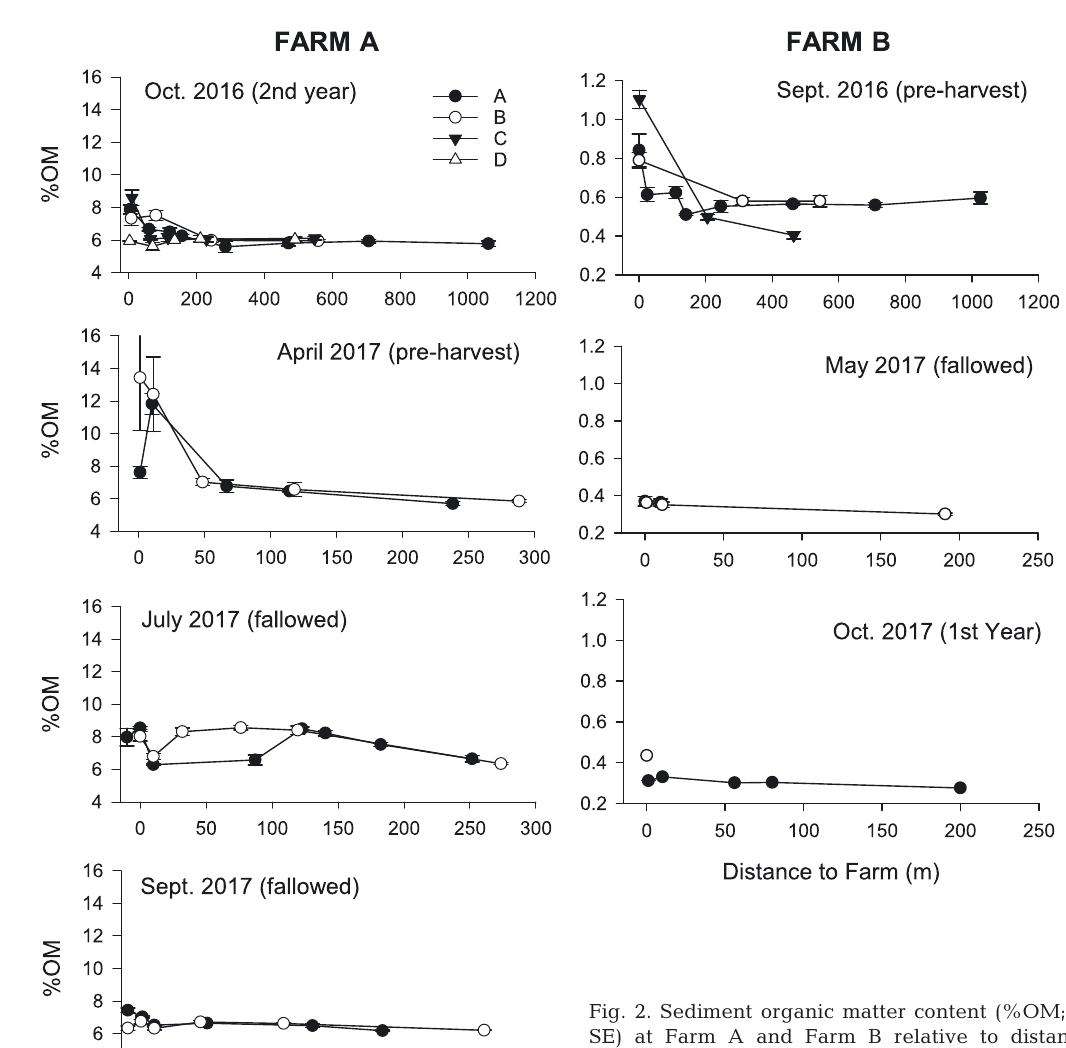
Fig. 2. Sediment organic matter content (%OM; mean ± SE) at Farm A and Farm B relative to distance from net-pens during different seasons and husbandry stages. Letters in the legend refer to sampling transects (A: pre- dominant current direction; B: opposite direction; C and D: orthogonal directions). Note different distance